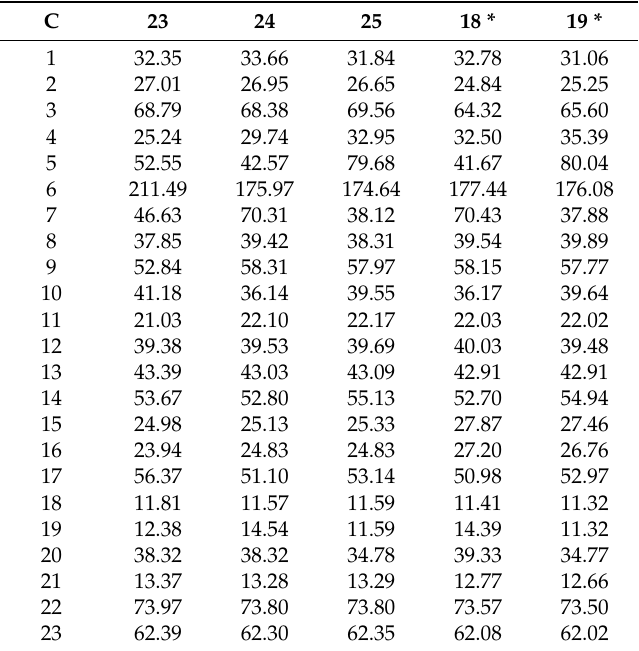
Table 2. δ (ppm) 13 C-NMR (CDCl 3 , 100.6 MHz) for compounds 18 , 19 , 23 – 25